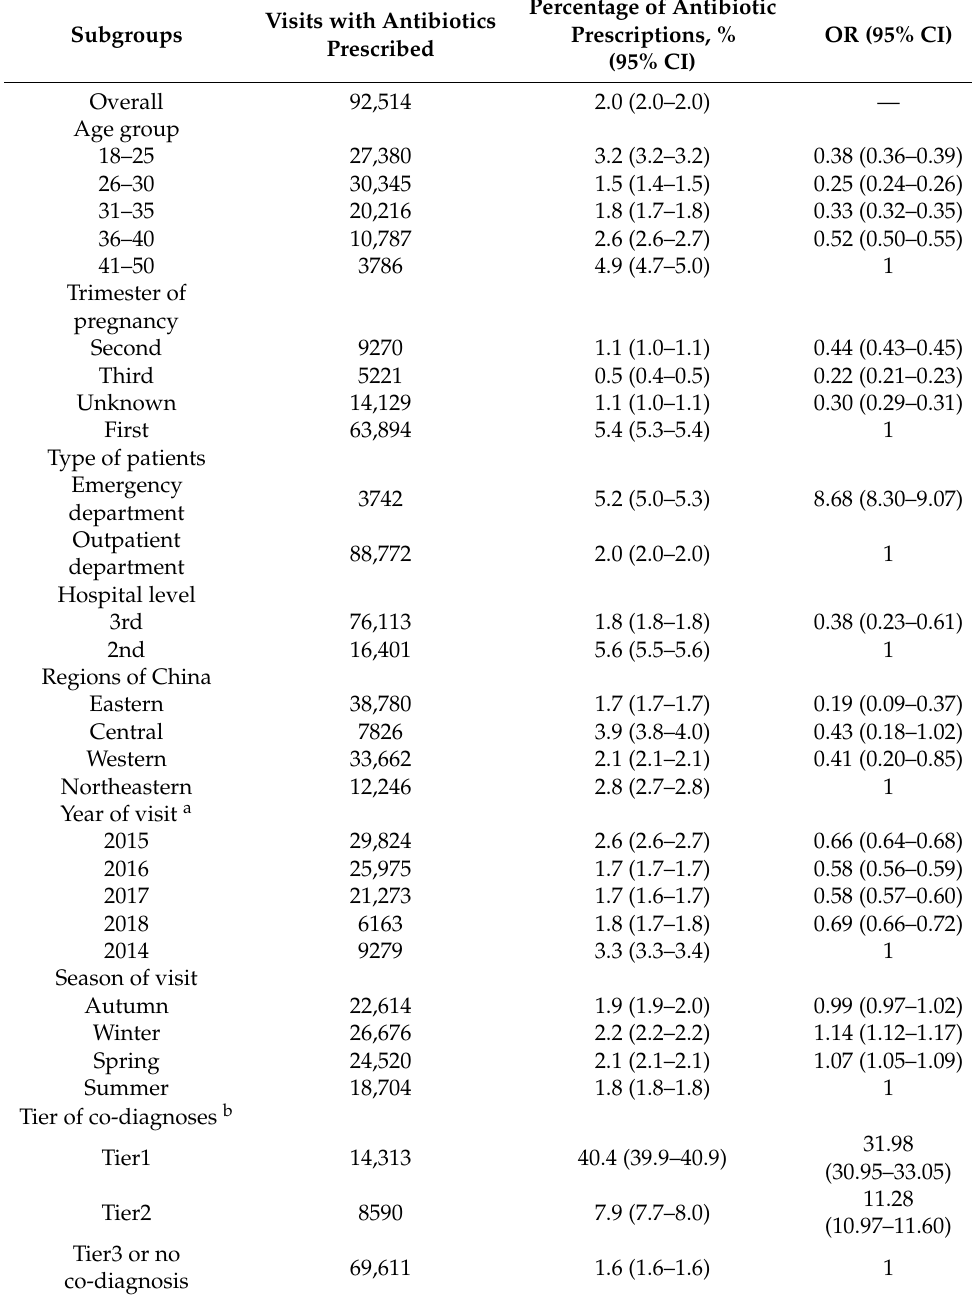
Table 2. Percentages of antibiotic prescriptions for various subgroups of ambulatory care visits by pregnant